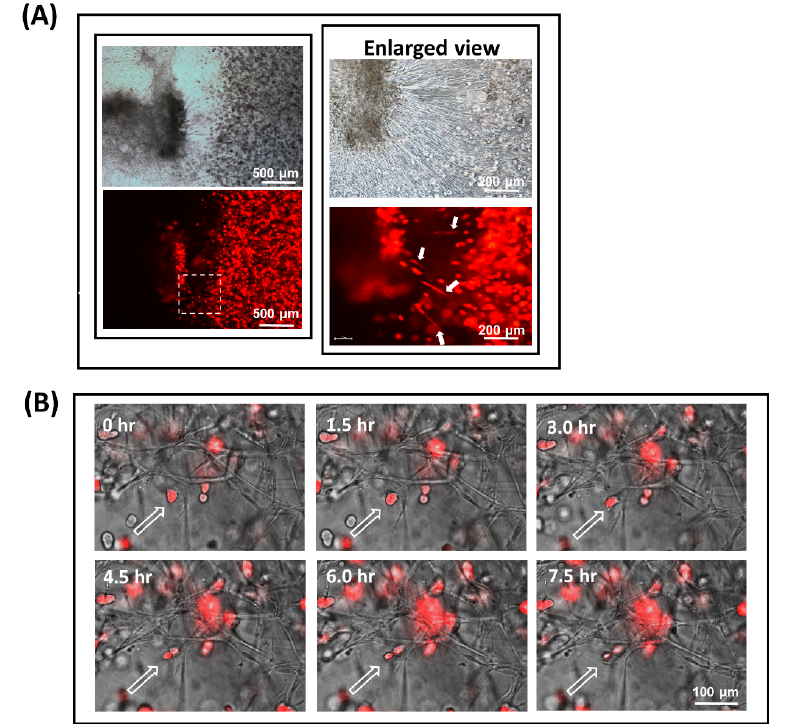
Figure 7. Fibroblast-guided cancer cell migration as viewed from the invasion front. Evidence demonstrating how the metastatic pathway of a cancer cell could potentially be affected by the fibroblast filaments it is in adherence to. ( A ) High-magnification images of the invasion front where fibroblasts and CaKi-1 cells first came into physical contact. Due to the elasticity and contractile motion of the pioneering filaments, some of the CaKi-1 cells in adherence to the fibroblasts appeared highly stretched and elongated (highlighted by arrows). ( B ) Time-lapse images showing a CaKi-1 cell (highlighted by an arrowhead) being coerced into a shifting position as the fibroblast filament it was attached to underwent contraction (see video in Supplementary 3).